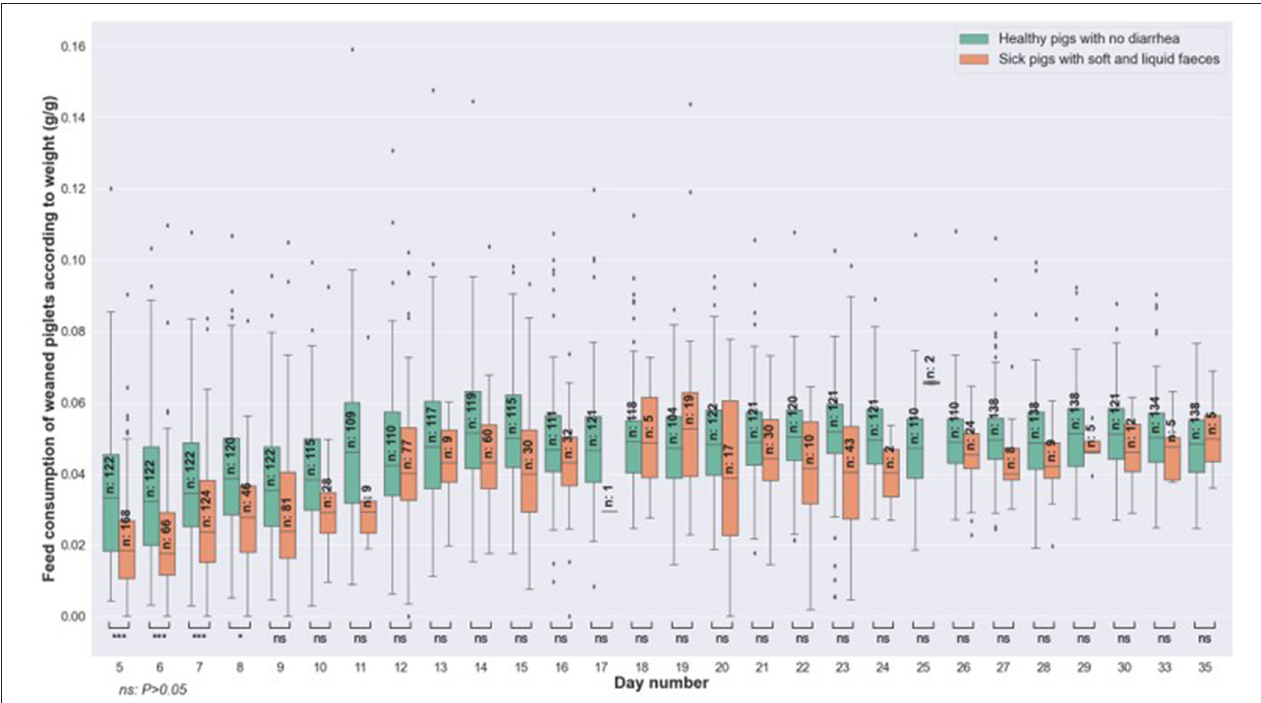
FIGURE 4 | Comparison of feed consumption related to weight, between healthy pigs (no diarrhea) vs. sick animals (with soft and liquid diarrhea) at the same age and on the day of onset of diarrhea.